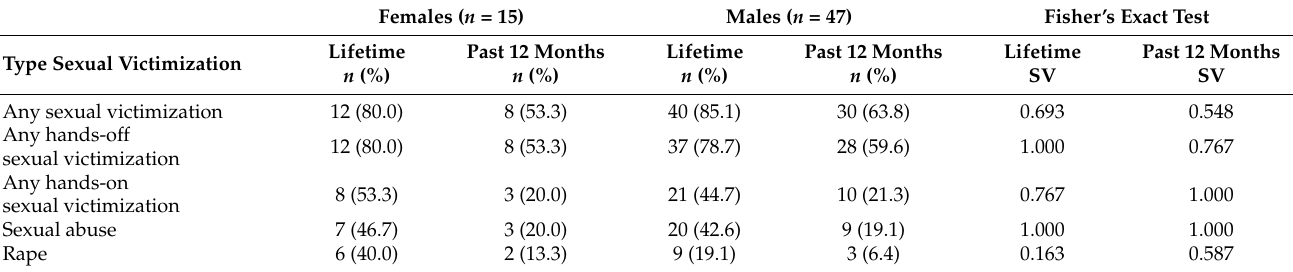
Table 3. Nature of lifetime sexual victimization and victimization in the past 12 months per sex at